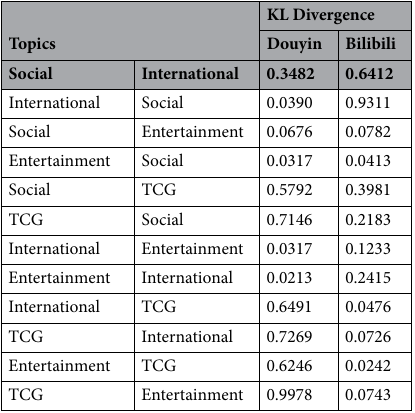
Table 3. User’s spatial location hierarchy criteria Kullback–Leibler divergence.